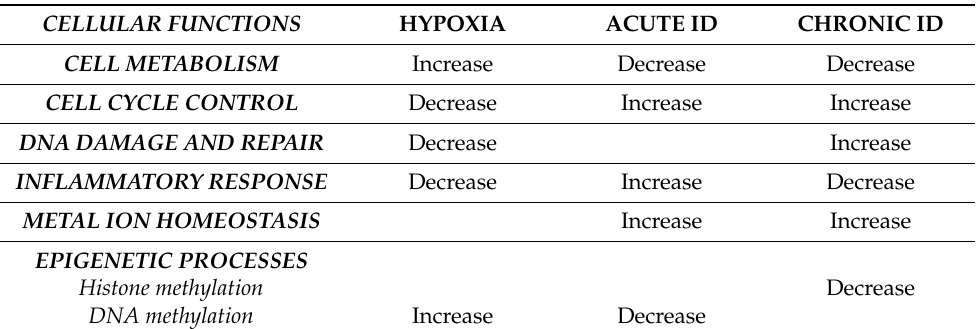
Table 1. Dynamics of protein phosphorylation pathways regulated by hypoxia, acute, and chronic iron deficiency. Functional activity is summarized either as increased, decreased, or unchanged (blank).